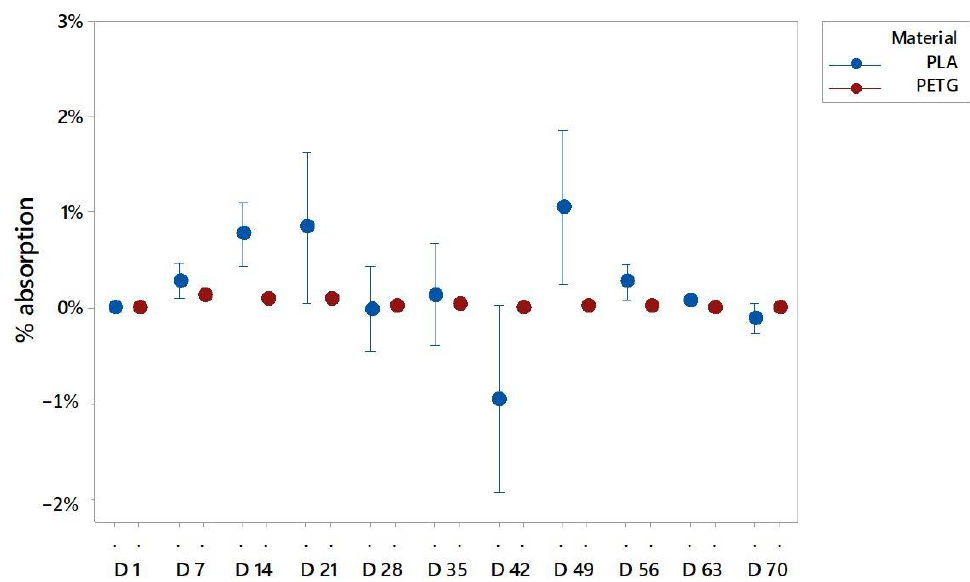
Figure 5. Water absorptions of PLA and PETG specimens in distilled water, where D is the day of the evaluation of absorption .